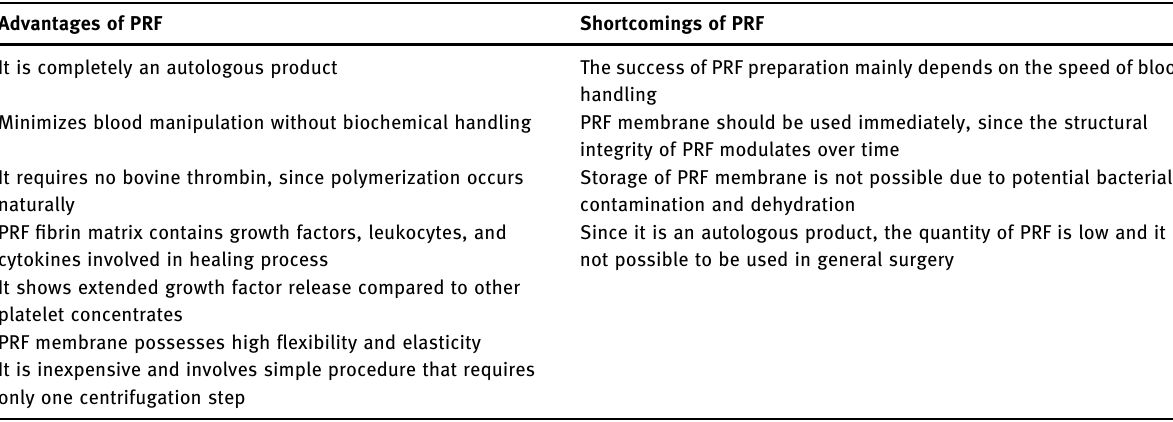
Table 1: Advantages and shortcomings of PRF Advantages of